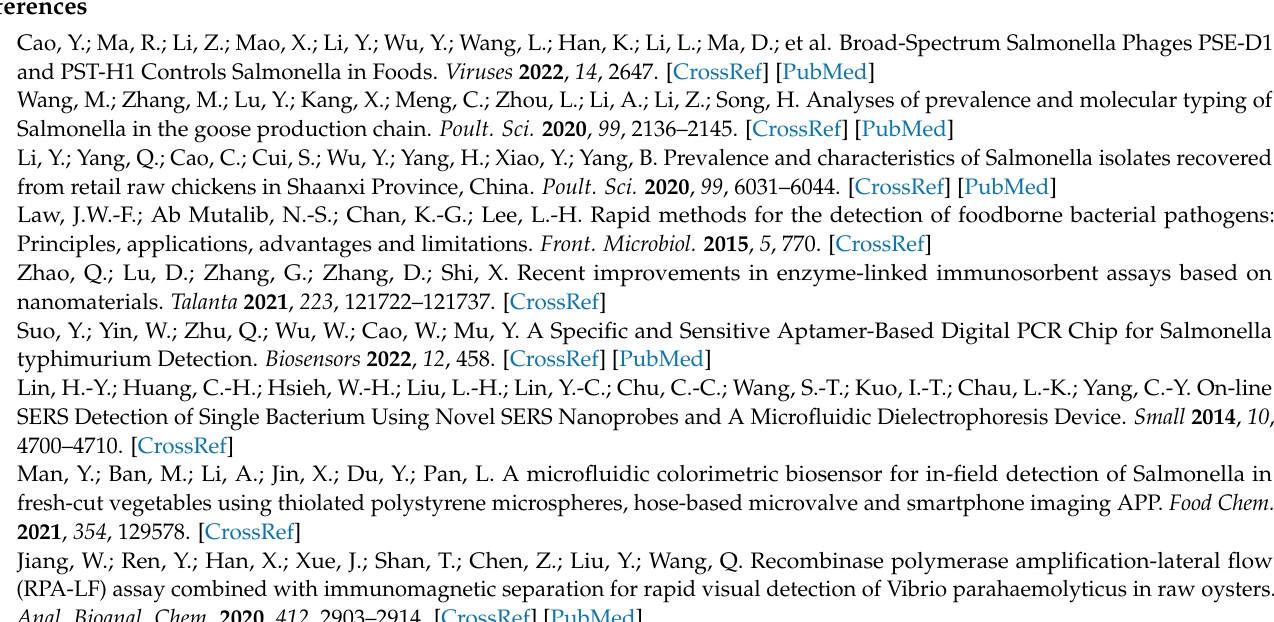
Table S2: The purify value of crRNA; Table S3: Comparison of this biosensor with some recently reported methods; Figure S1: Magnetic field simulation; Figure S2: The Ct values of this study compared with the method recommended by the manufacturer; Figure S3: Fluorescent intensity results of different incubation time; Figure S4: The PAM sequence